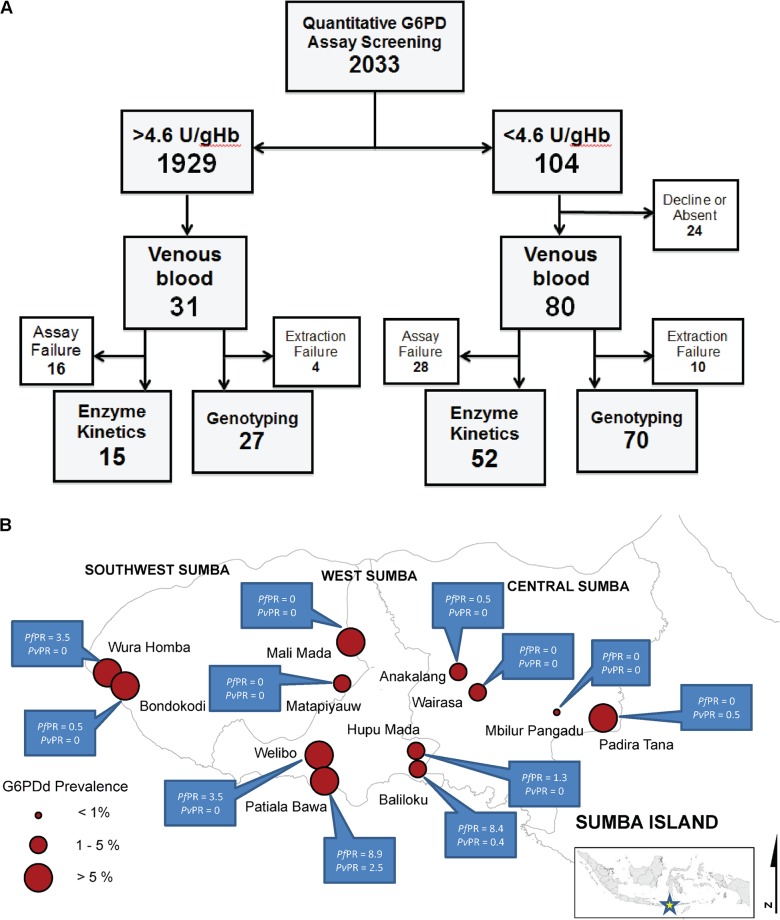
A) Schematic work flow of the study in western Sumba in 2012 and B) map of G6PD deficiency and malaria prevalences in study sites in Sumba.Small inlet showed the map of Indonesia and where Sumba island is located.